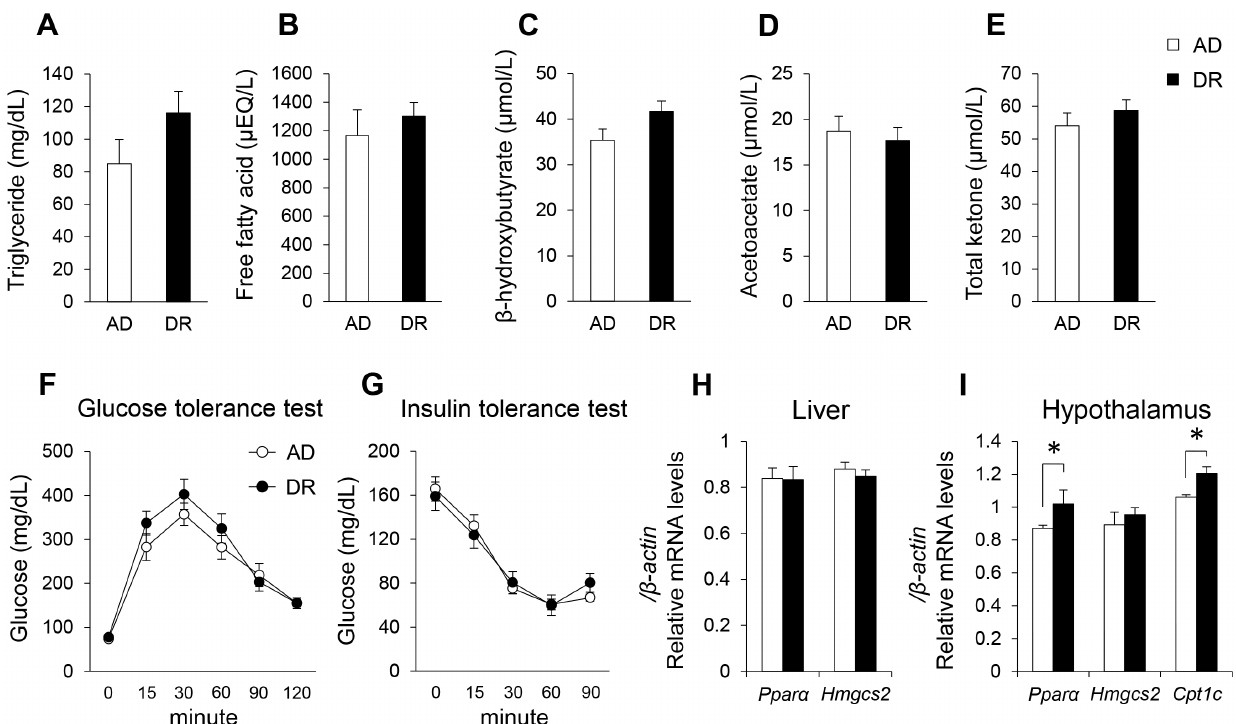
Figure 6. Metabolic state in adulthood (8–9 weeks). The plasma levels of triglycerides (A), free fatty acids (FFAs; B), b -hydroxybutyrate (C), acetoacetate (D), and ketone bodies (E). Glucose tolerance test (GTT; F) and insulin tolerance test (ITT; G) in adulthood. Gene expression related to the regulation of lipid metabolism in liver (H) and hypothalamus (I). Open bars and circles indicate AD mice. Closed bars and circles indicate DR mice. Data represent means 6 SEM (A–E; n=6, F, G; n=5–6, H; n=7, I; n=4–6). *p , 0.05 indicates a significant